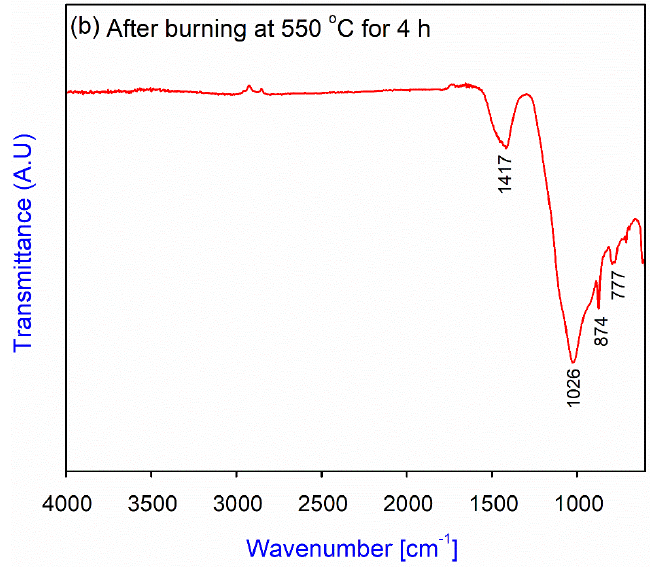
Figure 2. ( a ) XRD pattern, and ( b ) FTIR analysis results of WSA after heat treatment at 550 °C for 4 h.